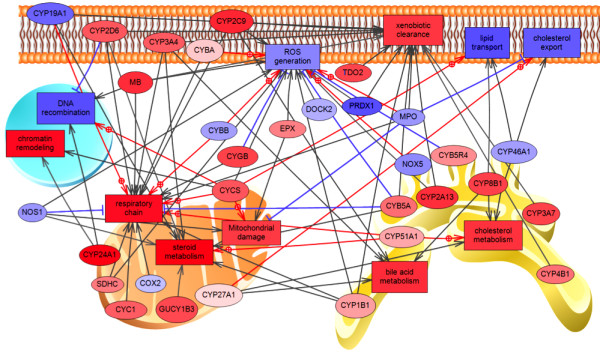
Pathway analysis of hepatic genes differentially regulated by 17β-trenbolone: Impacts on metabolic pathways. Connections between significantly up or down-regulated genes in the liver and enriched Biological Processes from human homolog data were visualized. The red color represents up-regulation by TB and blue color represents down-regulation by TB compared to the samples exposed to the vehicle control. The intensity of the color is correlated with the degree of differential regulation. Red solid lines represent positive regulation of gene expression, blue solid lines represent negative regulation of gene expression, and grey solid lines represent unknown direction of regulation. Oval shapes represent individual genes and boxes represent GO Biological Processes. Gene abbreviations: COX2: cyclooxygenase II; CYBA: cytochrome b-245, alpha polypeptide; CYBB: cytochrome b-245, beta polypeptide; CYB5A: cytochrome b5 type A (microsomal); CYC1: cytochrome c-1;CYCS: cytochrome c, somatic; CYGB: cytoglobin; CYP(number)(letter)(number) for all entries: cytochrome P450, family number, subfamily letter, polypeptide variant number; DOCK2: dedicator of cytokinesis 2; EPX: eosinophil peroxidase; GUCY1B3: guanylate cyclase 1, soluble, beta 3;MB: myoglobin; MPO: myeloperoxidase; NOS1: nitric oxide synthase 1; NOX5: NADPH oxidase, EF-hand calcium binding domain 5; PRDX1: peroxiredoxin 1; SDHC: succinate dehydrogenase complex, subunit C, integral membrane protein, 15 kDa; TDO2: tryptophan 2,3-dioxygenase.